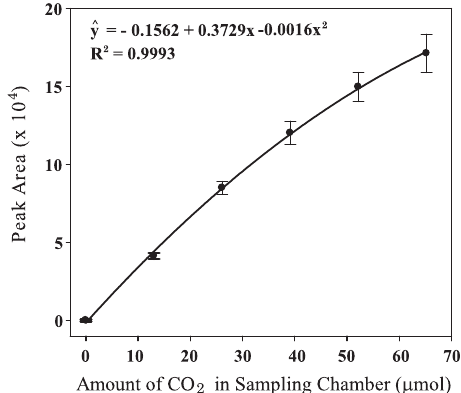
figure 3. calibration curve for co 2 analysis by gpfIA (mean ± sd, n =